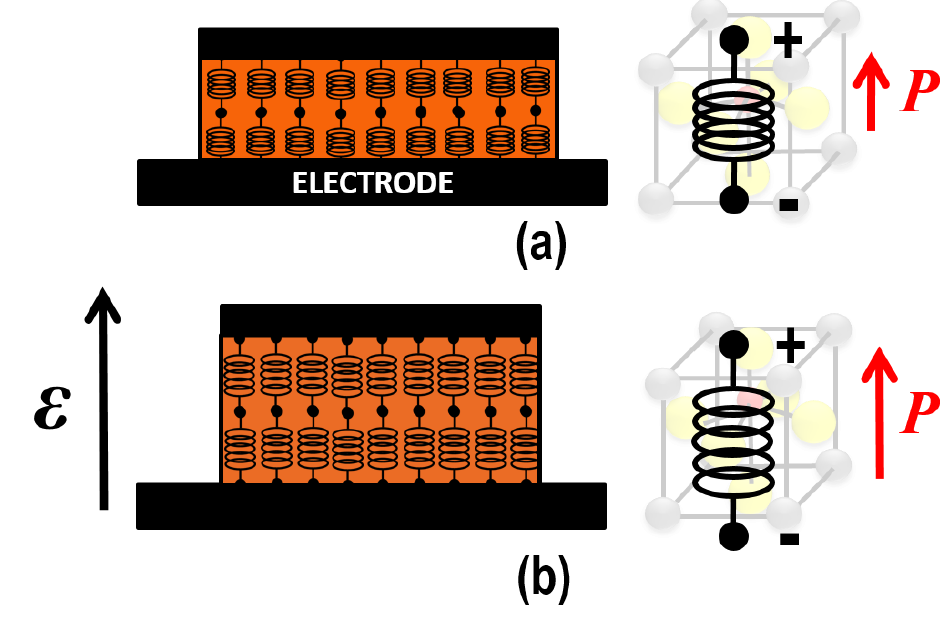
Figure 4. Illustration of the converse piezoelectric effect ( a ) at thermal equilibrium, and ( b ) when an external field has been applied. For illustration purposes, the change in thickness induced by this field has been exaggerated. In conventional piezoelectric materials, the polarization direction is fixed, while, in ferroelectric materials, the polarization depends on the electric field